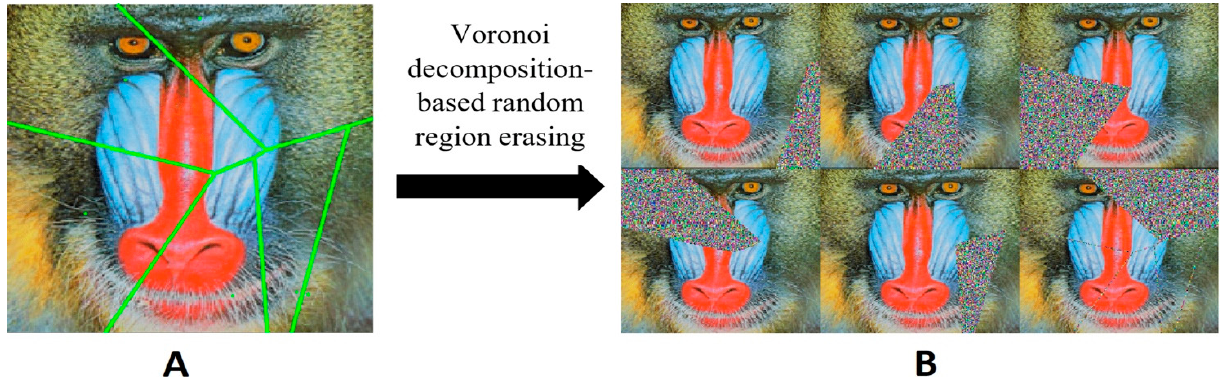
Figure 6. ( A ) An example image and its Voronoi decomposition and ( B ) example images generated using the proposed random region erasing method.